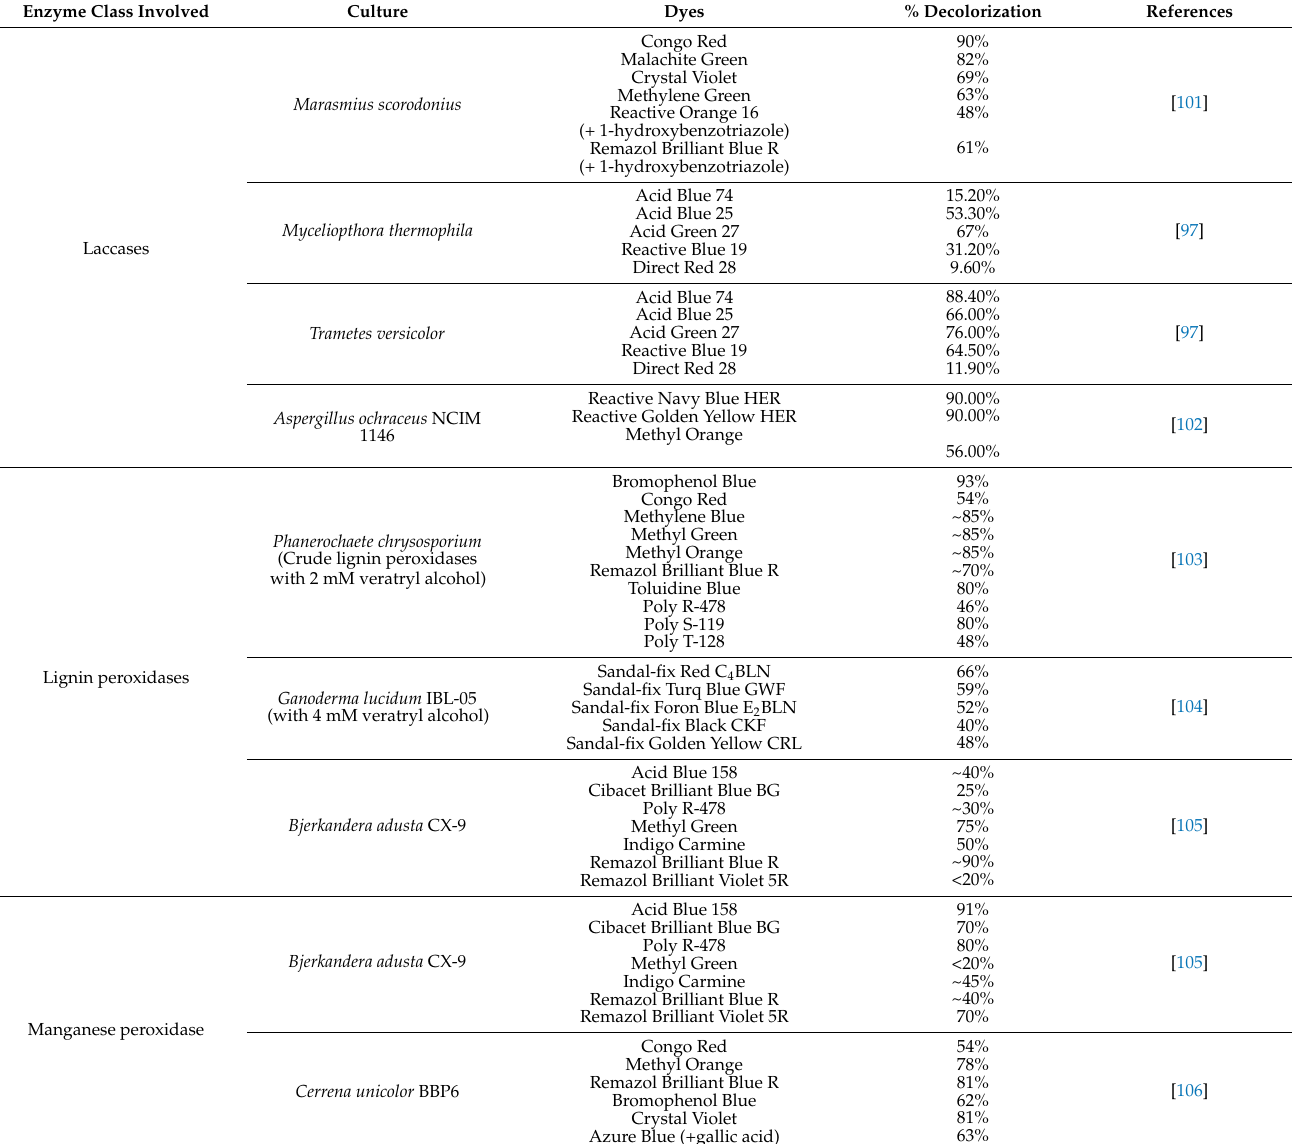
Table 1. List of fungal cultures from various decolorization studies and involved